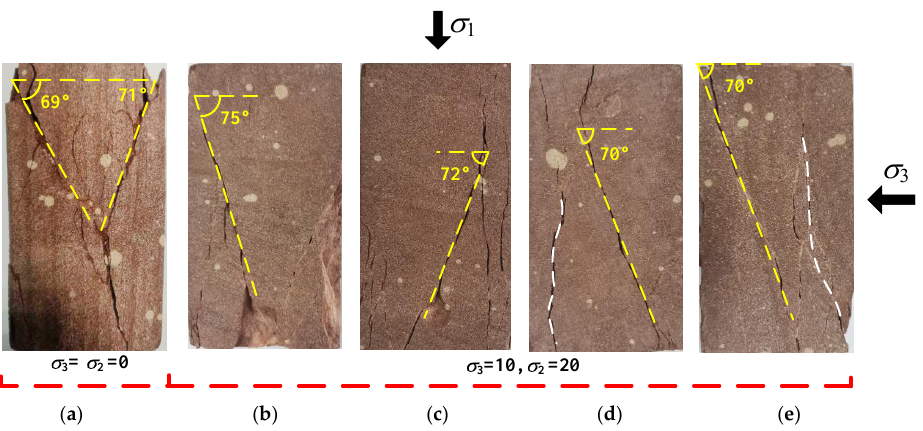
Figure 7. Failure modes of sandstone samples under true triaxial loading–unloading stress paths: ( a ) UC; ( b ) LCCT; ( c ) LCUT; ( d ) LUUT; ( e ) LLUT.